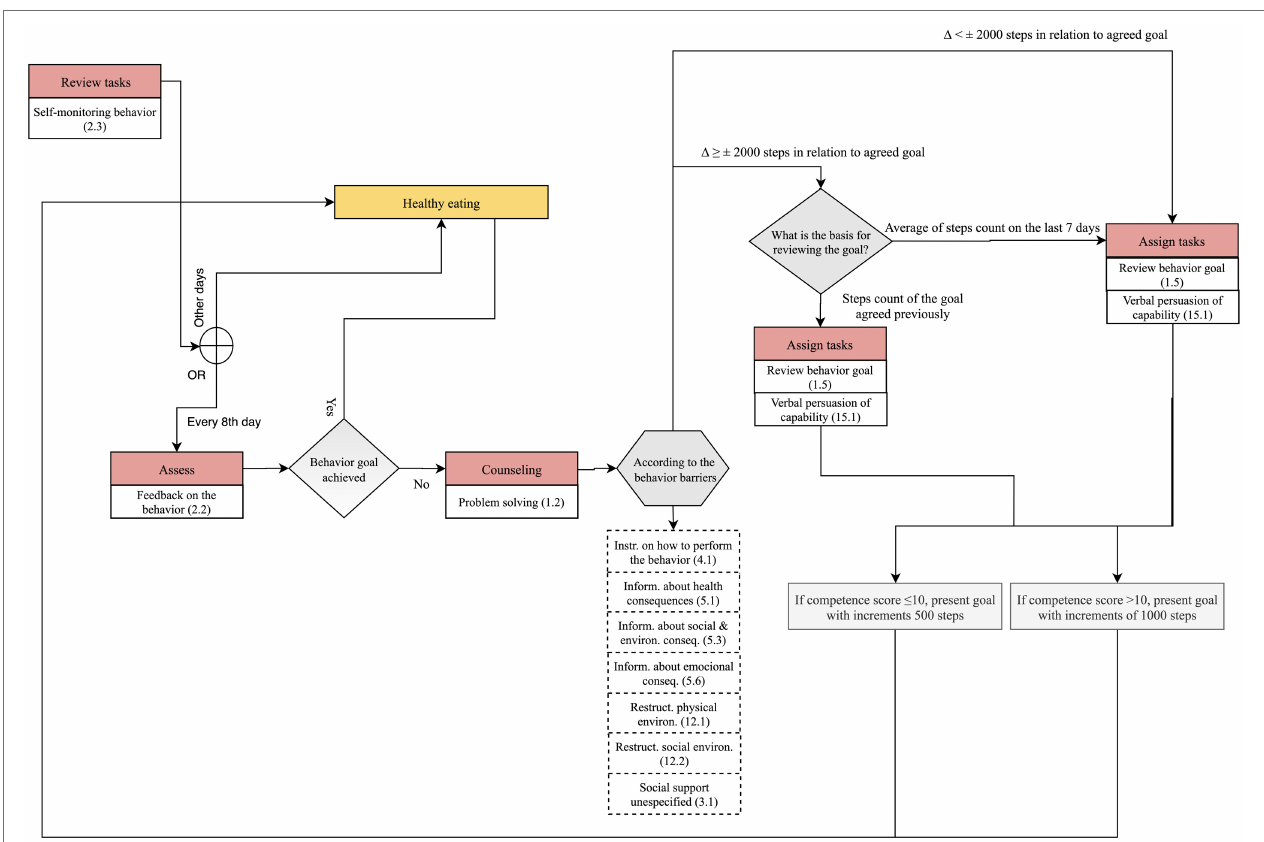
FIGURE 8 | Dialogue flow in “lite” physical activity